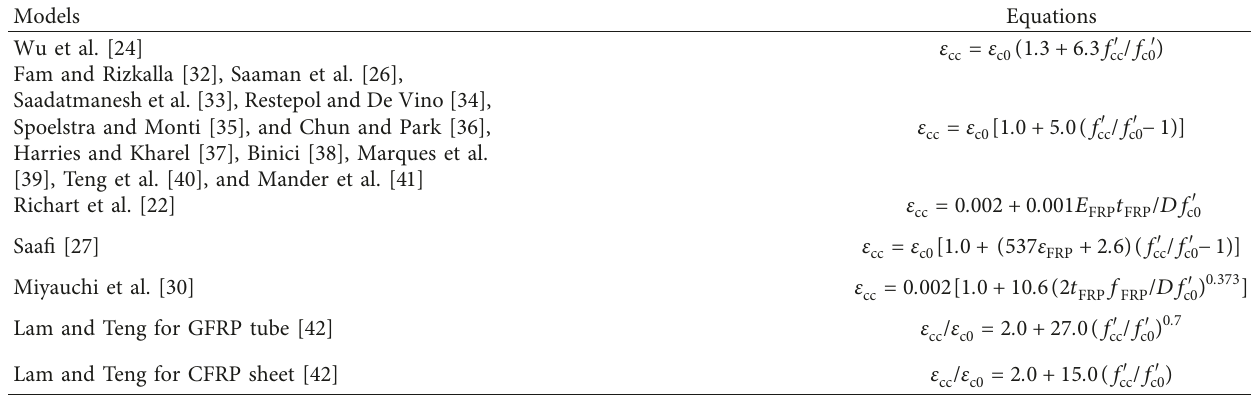
Table 7: Prediction models of the ultimate axial strain.